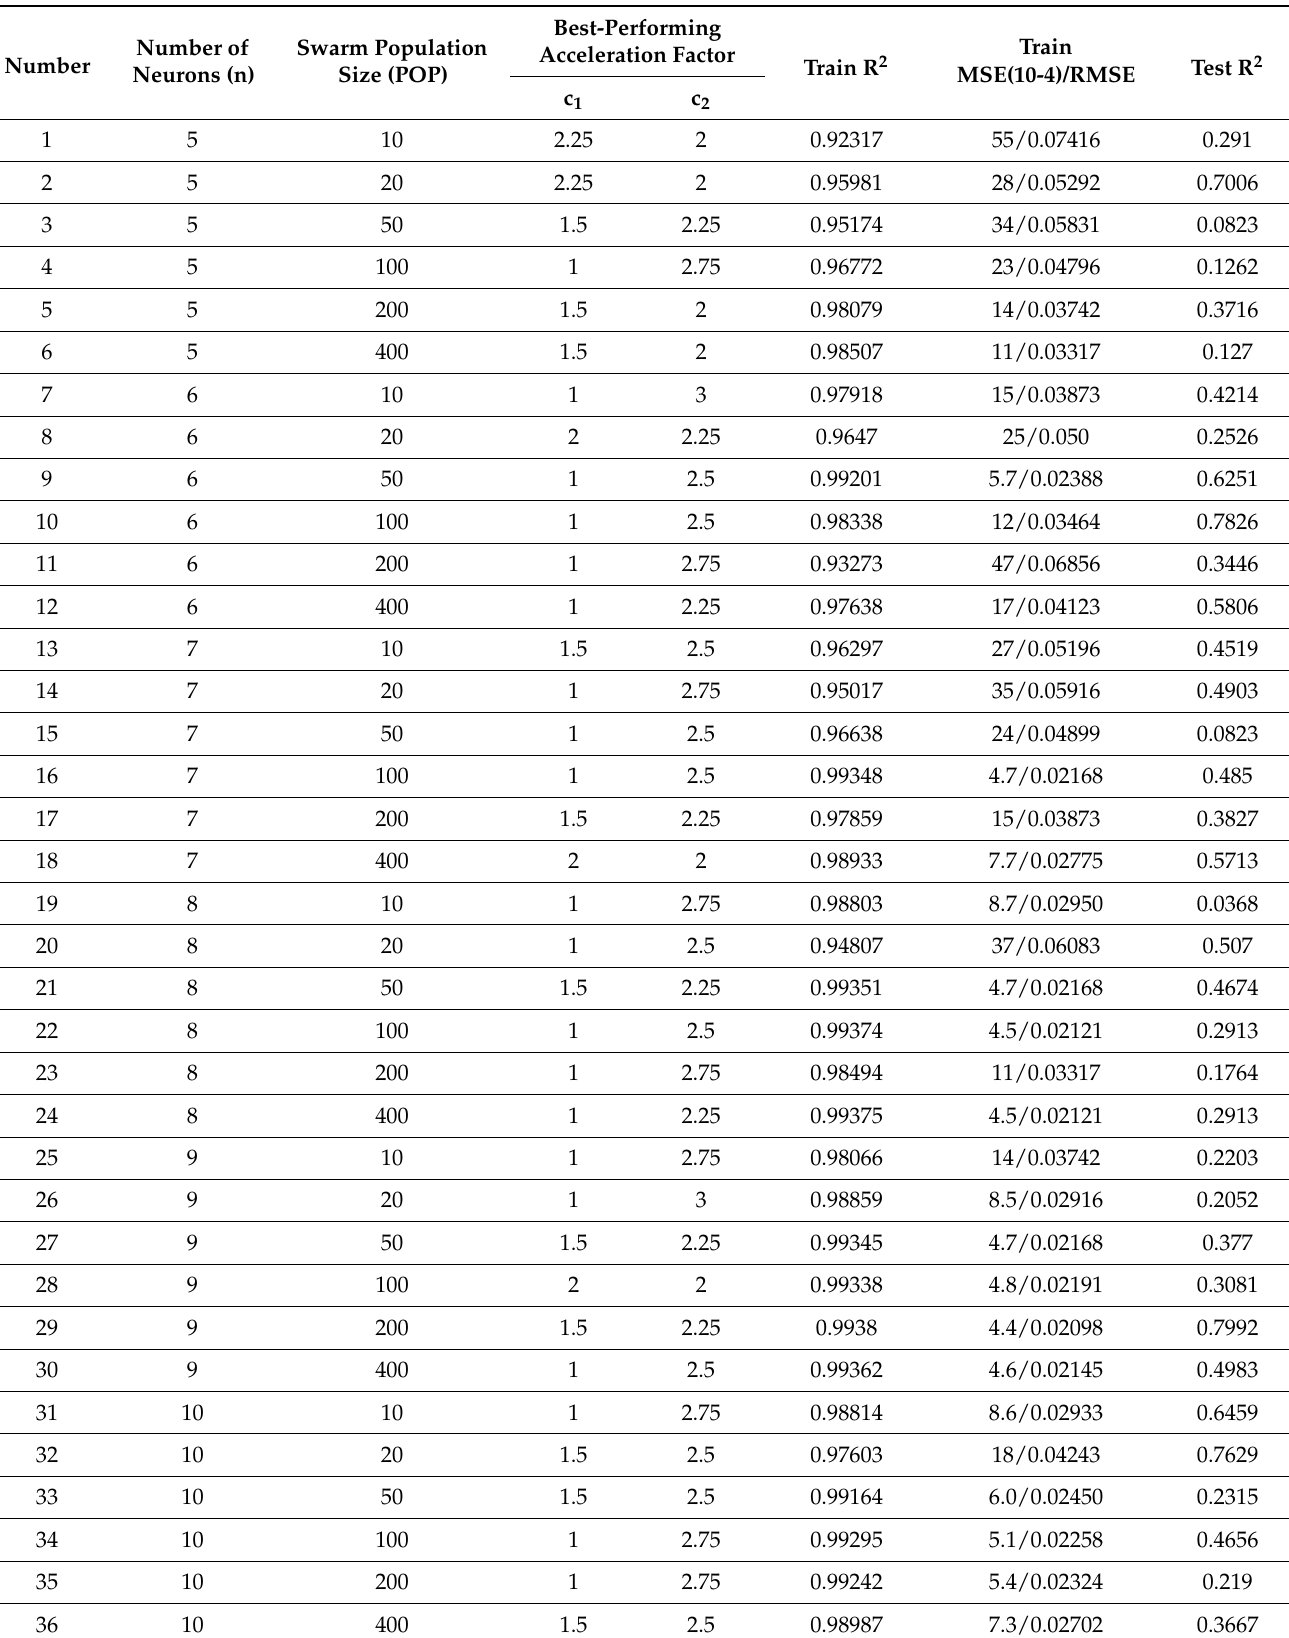
Table 5. Parametric results of the PSO-ANN hybrid